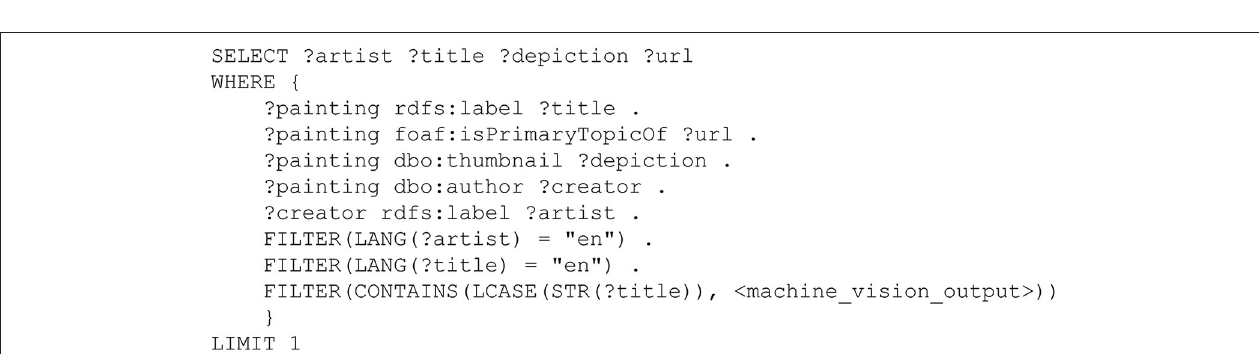
FIGURE 3 | The HoloArt application. (A) The user triggers the painting recognition process by using a voice command or air tap gesture. (B) The result of the painting recognition process (if successful) is rendered as a holographic display panel that is spatially anchored to the location of the painting. A virtual copy of the painting is included in the display panel for verification purposes.